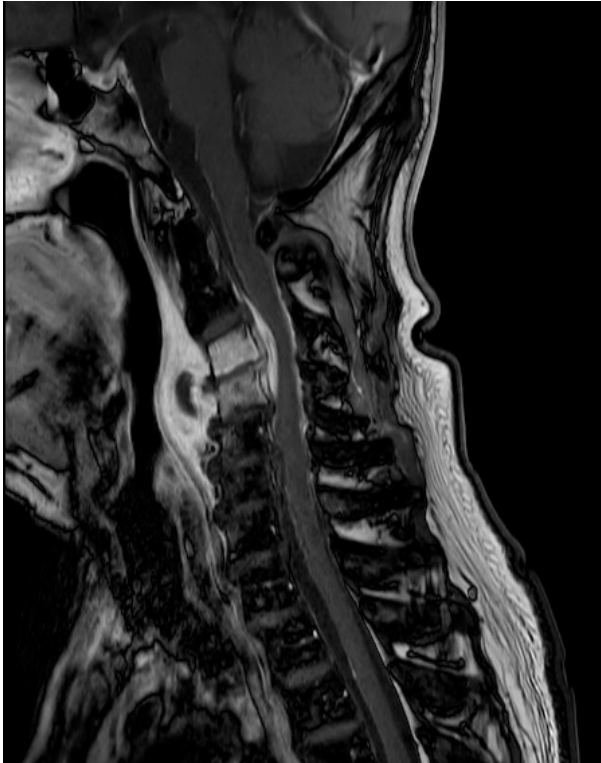
Figure 1. Magnetic resonance images showing infectious spondylitis with prevertebral abscess formation and anterior epidural abscess formation at the C3-C4 level, and a diffuse prevertebral soft tissue swelling/inflammation.